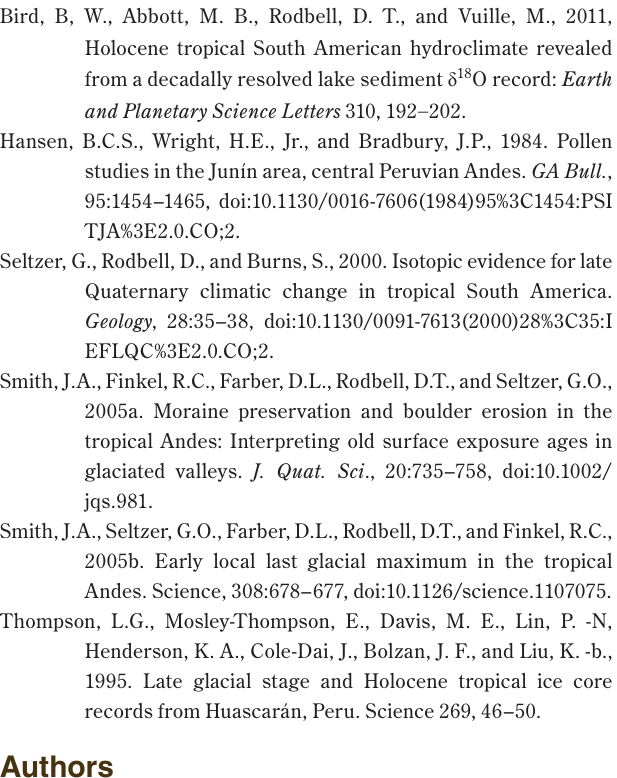
Fig. 2: Donald T. Rodbell, Union